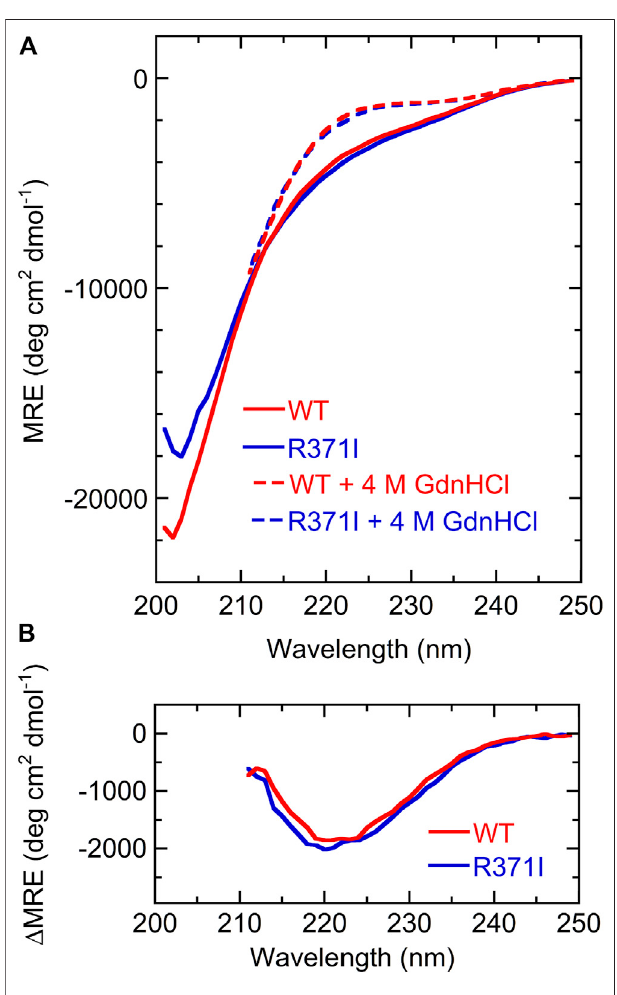
FIGURE 2 | CD measurements. (A) Far-UV CD spectra of the wild type (red) and R371I mutant (blue) of Int8 in the absence (continuous lines) and presence (broken lines) of 4 M GdnHCl. The MRE values are shown. The spectra in the presence of 4 M GdnHCl were measured up to 211 nm due to large absorption by GdnHCl at lower wavelengths. (B) Difference CD spectra calculated by subtracting the CD spectrum in the presence of 4 M GdnHCl from that measured in the absence of